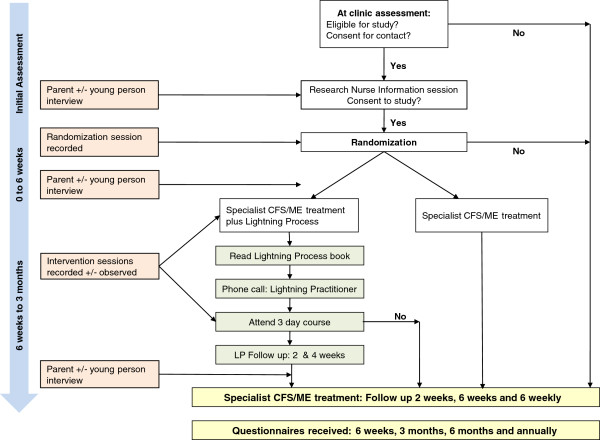
Protocol flow chart.